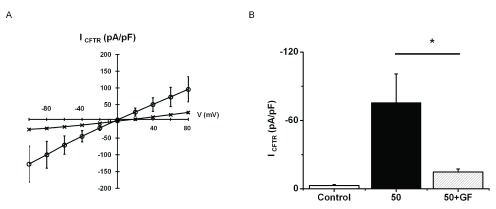
Stimulation of F508del-CFTR activity by TNFα is blocked by PKC inhibitor (GF109203X). Whole cell Cl
- currents recorded in HeLa cells expressing F508del-CFTR by patch-clamp experiments.* indicates significant results.
A. Mean CFTR-related current-voltage relationships. Current densities normalized to cell capacitance (pA/pF) were measured in the presence of 50 ng/ml TNFα (
O); on cells treated for 30 min by 5µM GF109203X in the presence of TNFα (
X).
B. Mean CFTR current amplitudes recorded at -60 mV and normalized to cell capacitance in untreated cells (control; mean + SEM; n=8), in cells treated for 10 minutes by TNFα (50; means + SEM, n=8) and in cells treated by 5 µM GF109203X for 30min and for 10 minutes by TNFα (50+GF; means + SEM, n=6). Statistics: non-parametric unpaired Student’s t test between (50) and (50 + GF), p=0.047.